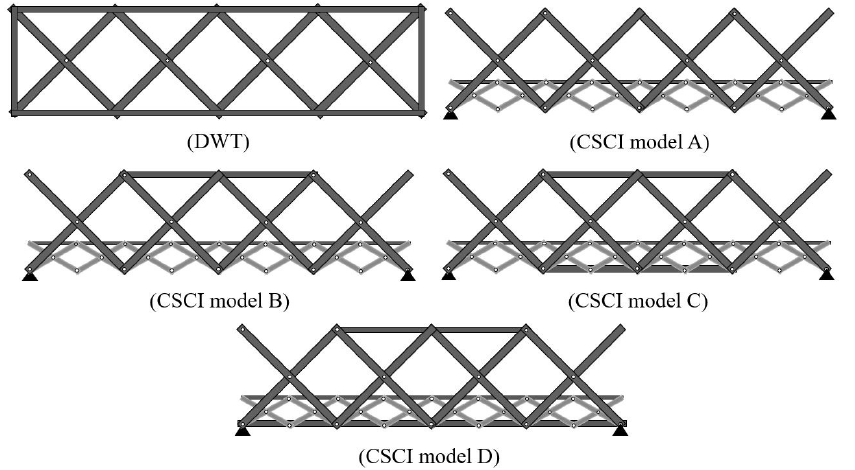
Figure 13. The types of structural